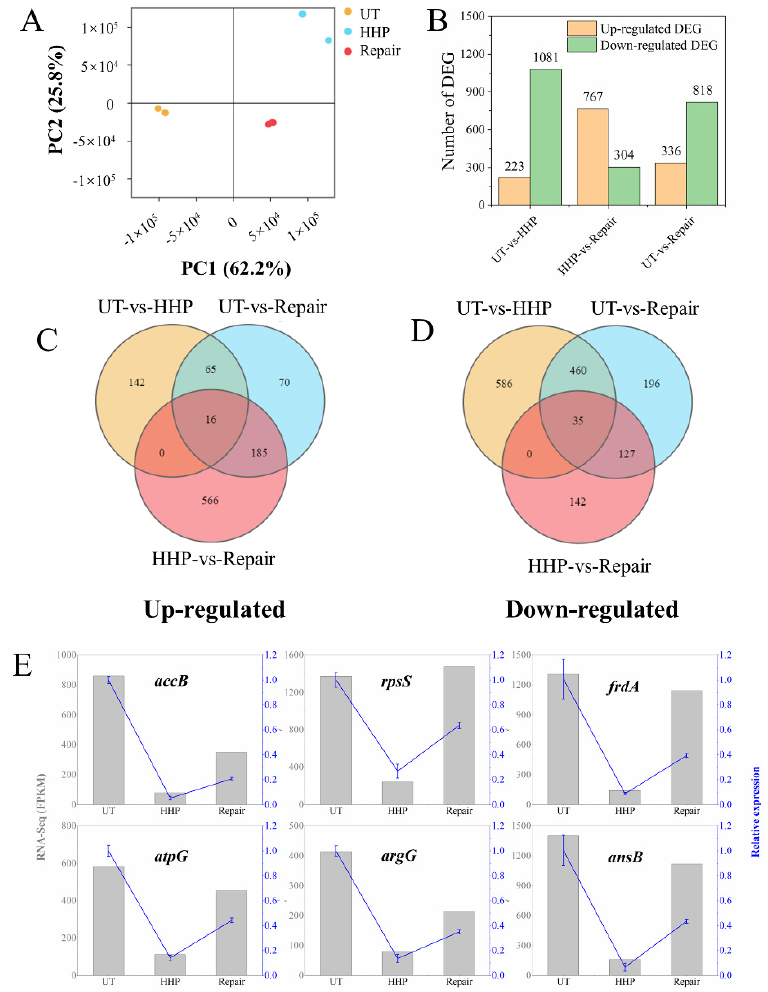
Figure 3. Analysis of the E. coli O157: H7 transcriptome in HHP (sub-lethal cells) and repair (repaired in liquid medium for 2 h) groups. ( A ) the principal component analysis of UT, HHP, and repair groups. ( B ) The upregulated and downregulated differentially expressed genes (DEGs) among UT vs. HHP, HHP vs. repair, and UT vs. repair. ( C , D ) The Venn diagram analysis of upregulated and downregulated DEGs enriched in both the HHP and repair groups, respectively. ( E ) The qRT-PCR results of the 6 DEGs, which were the mean values of 2 − ∆∆ CT obtained from three biological replicates with error bars representing standard deviations. Results were normalized using 16S rRNA and expressed as fold